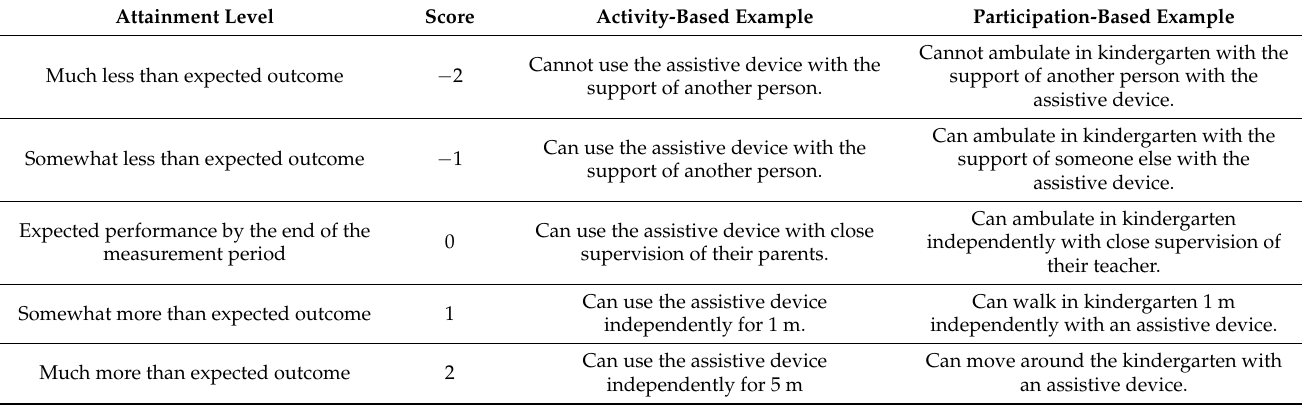
Table 1. Goal-attainment scale